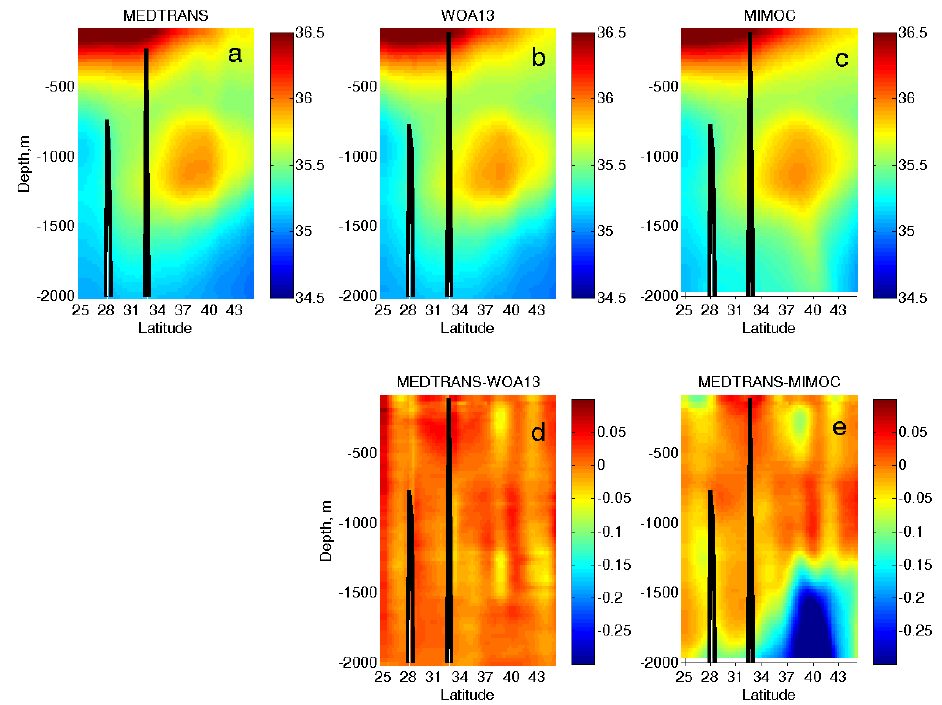
Figure 6. Meridional sections of salinity along 17 ◦ W: (a) MEDTRANS, (b) WOA13, (c) MIMOC, (d) MEDTRANS minus WOA13, and (e) MEDTRANS minus MIMOC.